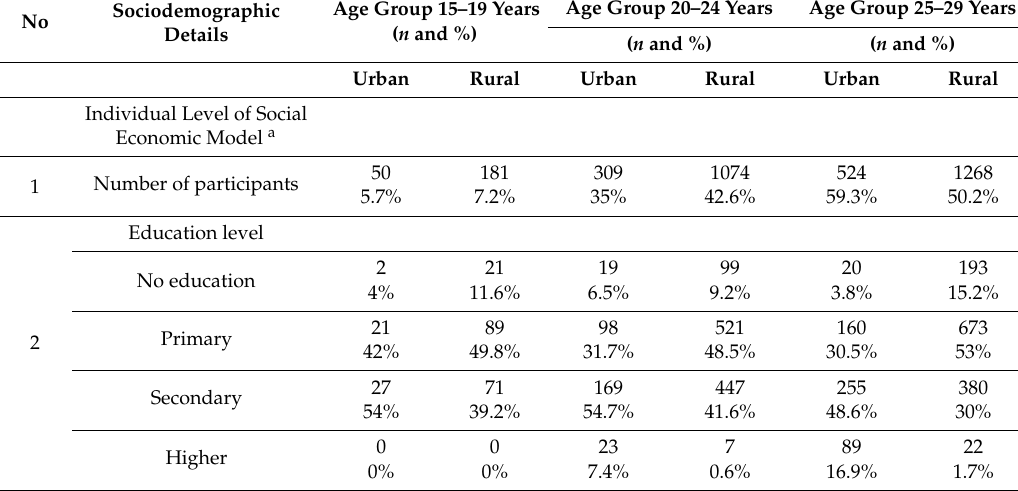
Table 1. Percent distribution of sociodemographic details of Cambodian urban and rural sexually active, single, in union or married females 15–29 years old, the 2014 Cambodian Demographic